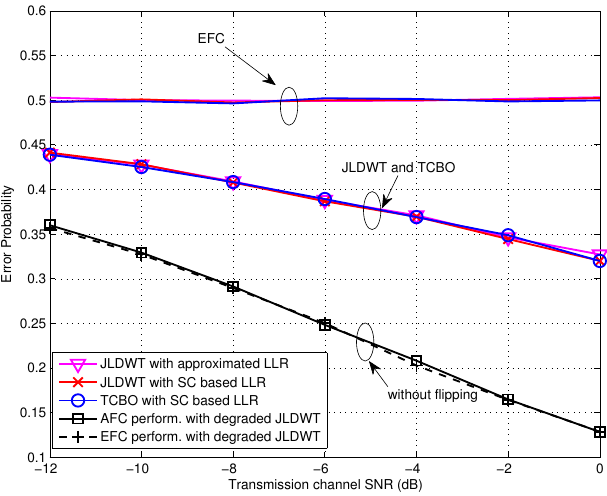
Figure 8. Error probabilities of TCBO and JLDWT schemes as functions of various SNR for β = 0.8 and snr L = 0 dB over low SNR